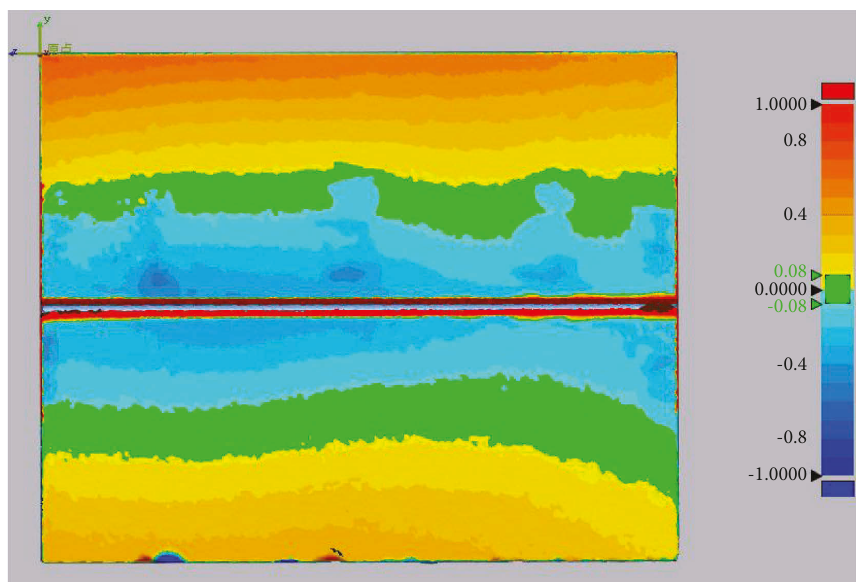
Figure 5: Vertical deformation cloud diagram (unit: mm).